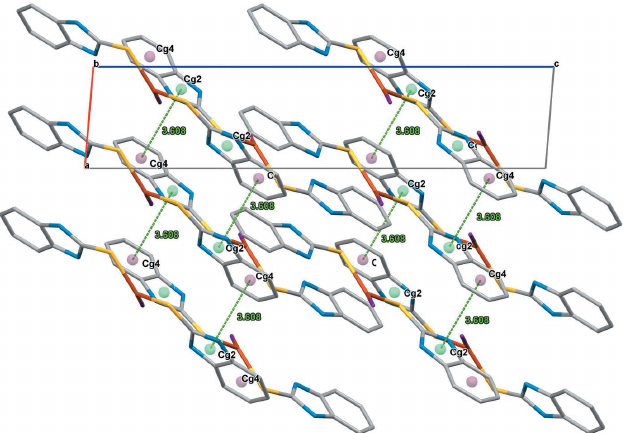
Figure 5 The intermolecular (cid:2) – (cid:2) interactions in the crystal packing of ( 2 ) plotted down the b axis.